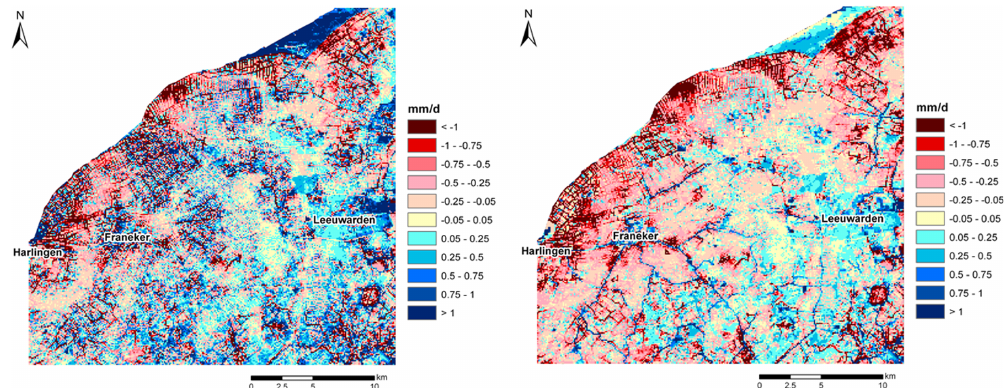
Fig. 17. Seepage and infiltration patterns under the first confining layer in the winter (left panel) and the summer (right panel) of 2005.